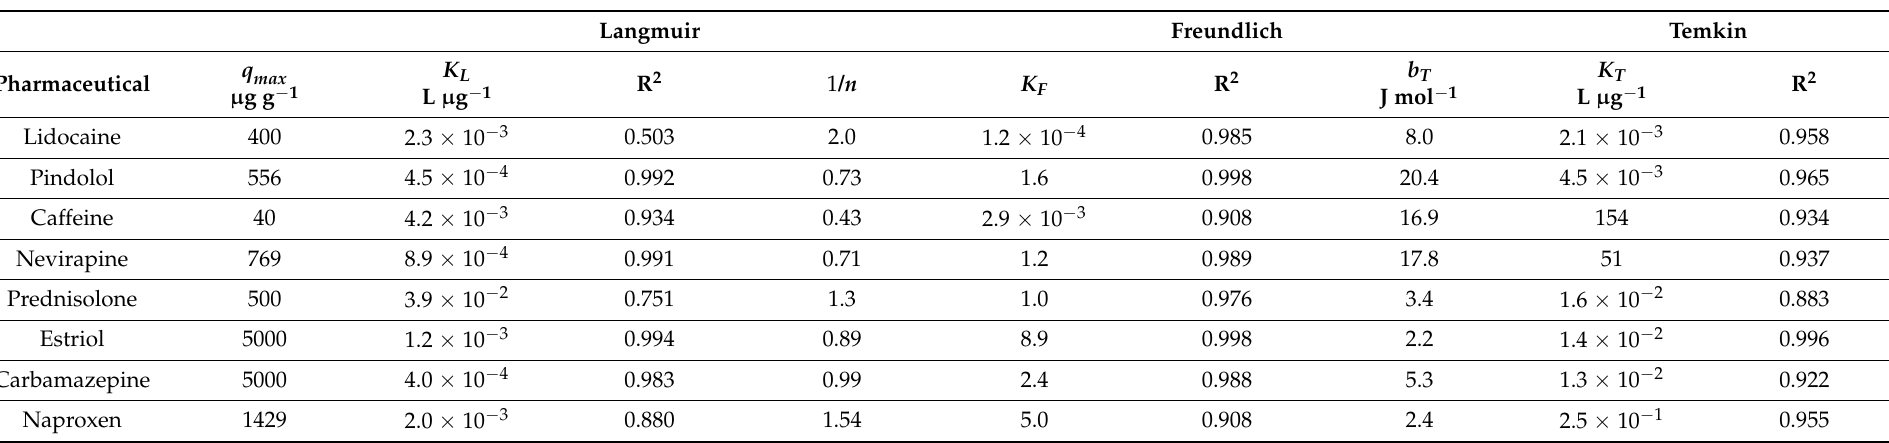
Table 3. Adsorption isotherm